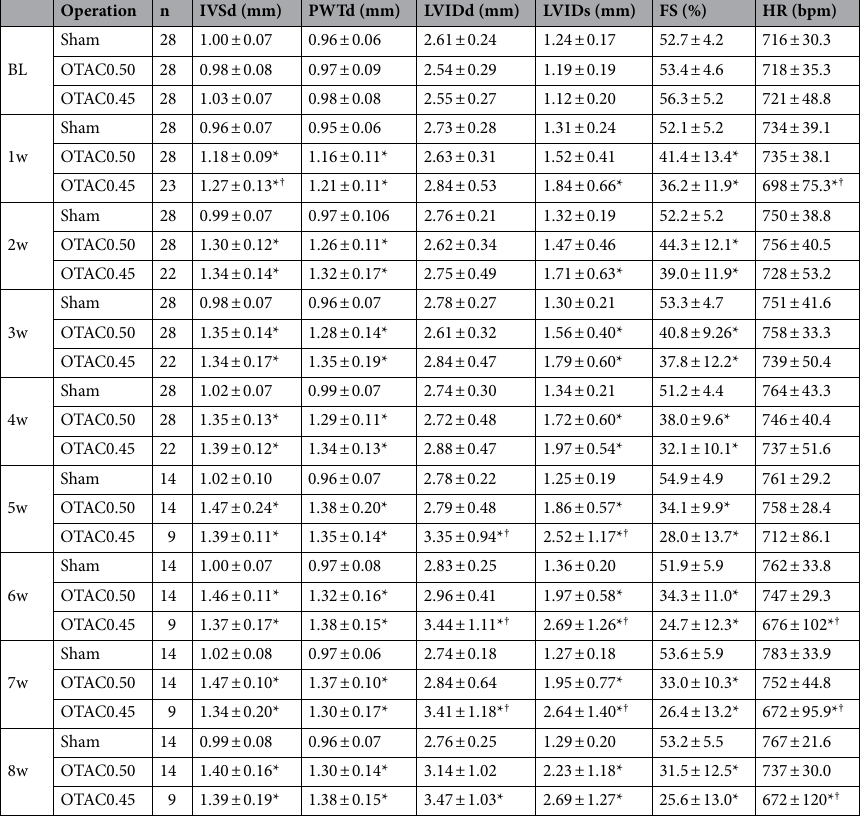
Table 3. Echocardiographic characteristics of mice subjected to OTAC and sham procedures. Data are expressed as the mean ± standard error of the mean. M-mode echocardiographic measurements of cardiac dimensions and function in sham-operated and O-ring-induced transverse aortic constriction (OTAC) mice at baseline (BL), 1, 2, 3, 4, 5, 6, 7 and 8 weeks after surgery. O-rings had inner diameters of 0.50 mm and 0.45 mm. Structural dimensions were measured in diastole (d) and systolic (s). IVS; interventricular septum, PWT; left ventricular posterior wall thickness, LVID; left ventricular inner diameter, FS; fractional shortening, HR; heart rate, BW; body weight. Repeated measures two-way ANOVA with Tukey’s post-hoc test was used (*P < 0.05 vs. Sham, † P < 0.05 vs. OTAC